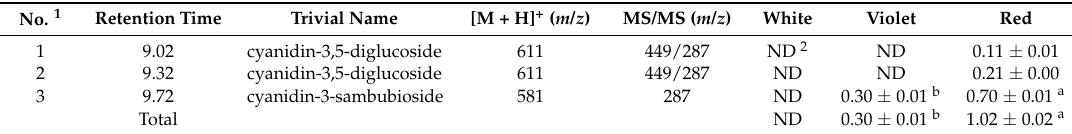
Table 1. Anthocyanin contents (mg/g dry wt.) of different colored flowers of Rhododendron schlippenbachii . No. 1